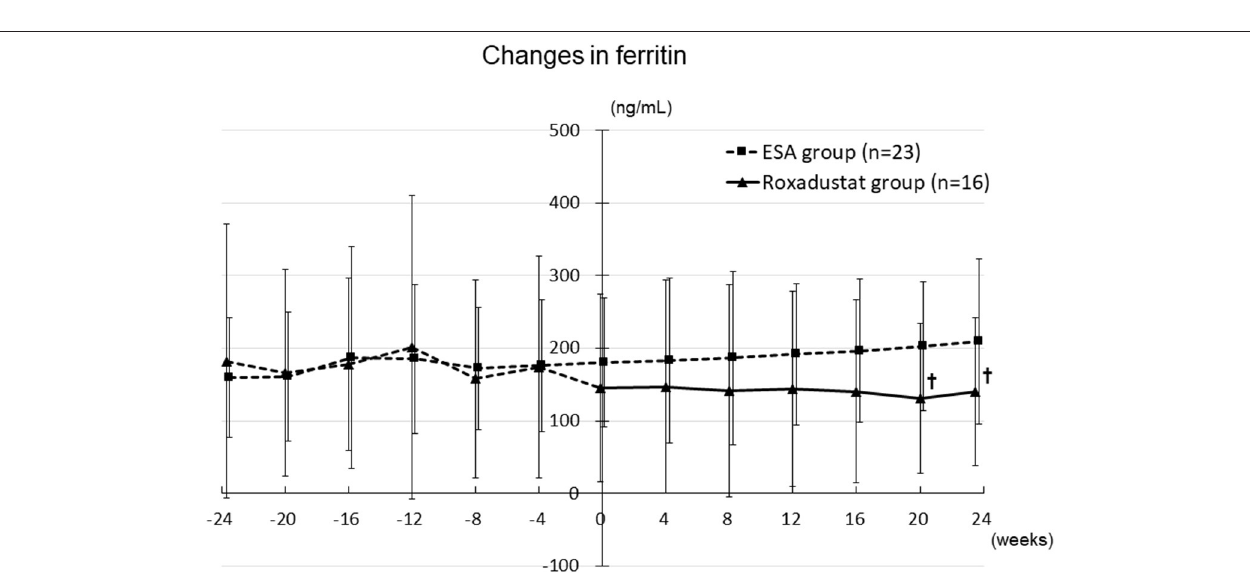
concentration in patients with CKD and anemia (6). A recent clinical trial showed that roxadustat maintains the hemoglobin concentrations of patients undergoing peritoneal dialysis who are switched from an ESA (8). In this trial, the mean dose of roxadustat was not reduced and was 213.3 mg/week at 22 weeks in the ESA-Converted group. In the present study, the mean dose of roxadustat was almost unchanged and was 189 mg/week at 24 weeks, which is similar to the dose reported previously (8). In the present study, roxadustat increased the